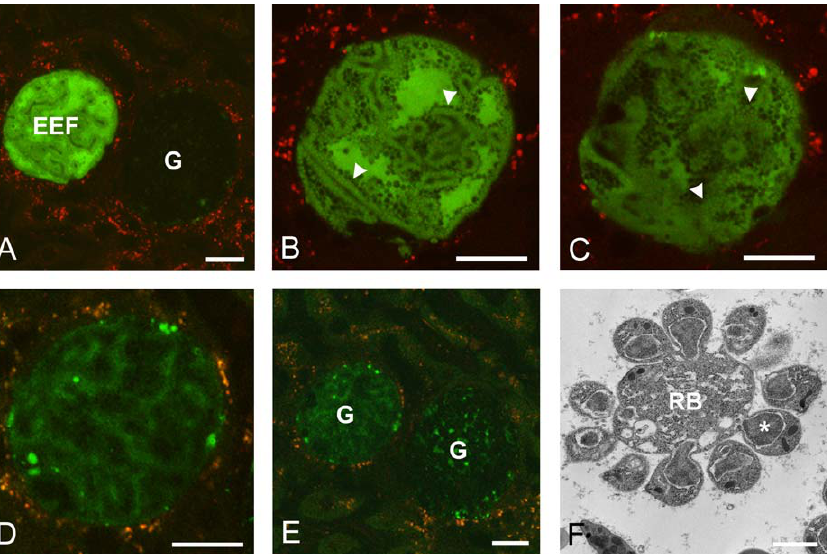
Figure 3. Rapid EEF Decay (A–D) Individual frames from an intravital video showing the process of liver stage transformation into an EEF ghost (see Video S5). (A) The still image shows an intact EEF adjacent to a ghost. G, ghost. (B) Individual frame showing rapid decay of the EEF shown on the left of (A). Note that loss of cytosolic GFP reveals the presence and arrangement of the merozoites (arrow). (C–D) Only a few of the thousands of merozoites remain visible in the faintly fluorescent EEF ghost. (E) Eventually, the infected hepatocyte has transformed into an EEF ghost. Note that both ghosts retain close contact with the surrounding tissue (A–E). Bars ¼ 20 l m. (F) Electron micrograph showing a liver sinusoid with merozoites that are incompletely separated from a remnant body. RB, remnant body; G, ghost; *, merozoite. Bar ¼ 1 l m.